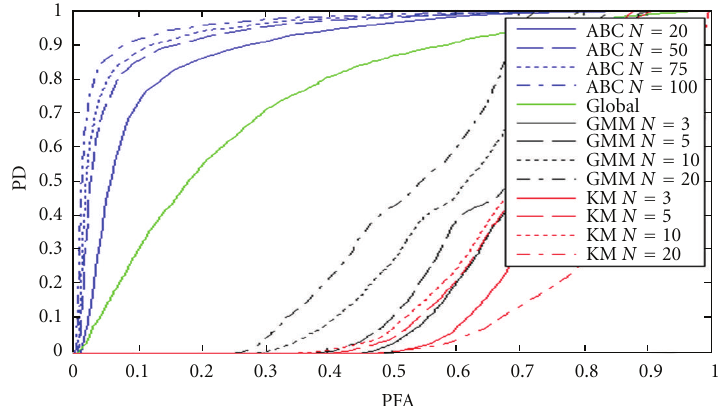
Figure 13: ROC curve performance testing QG-SemiP (ABC), global RX (global), k means (KM), and GMM detectors on scene shown in Figure 10.